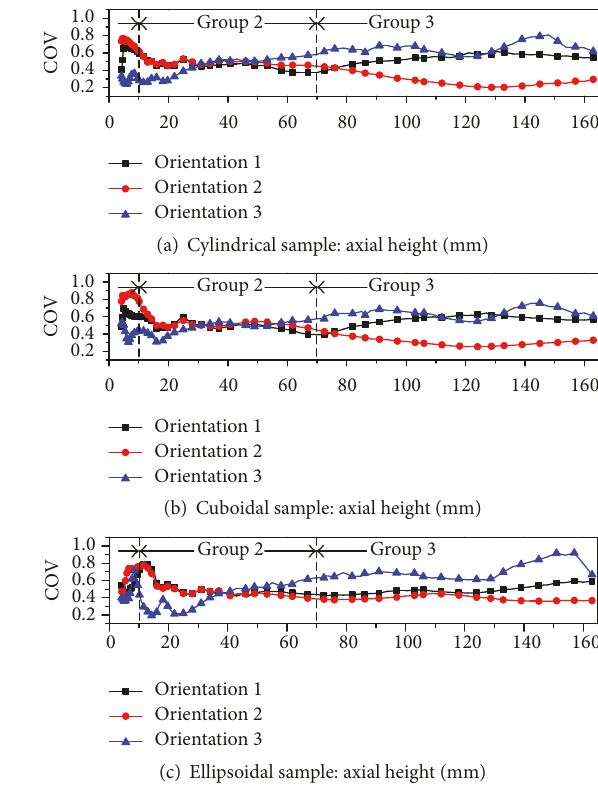
Figure 30: COV of the same samples in different orientations.